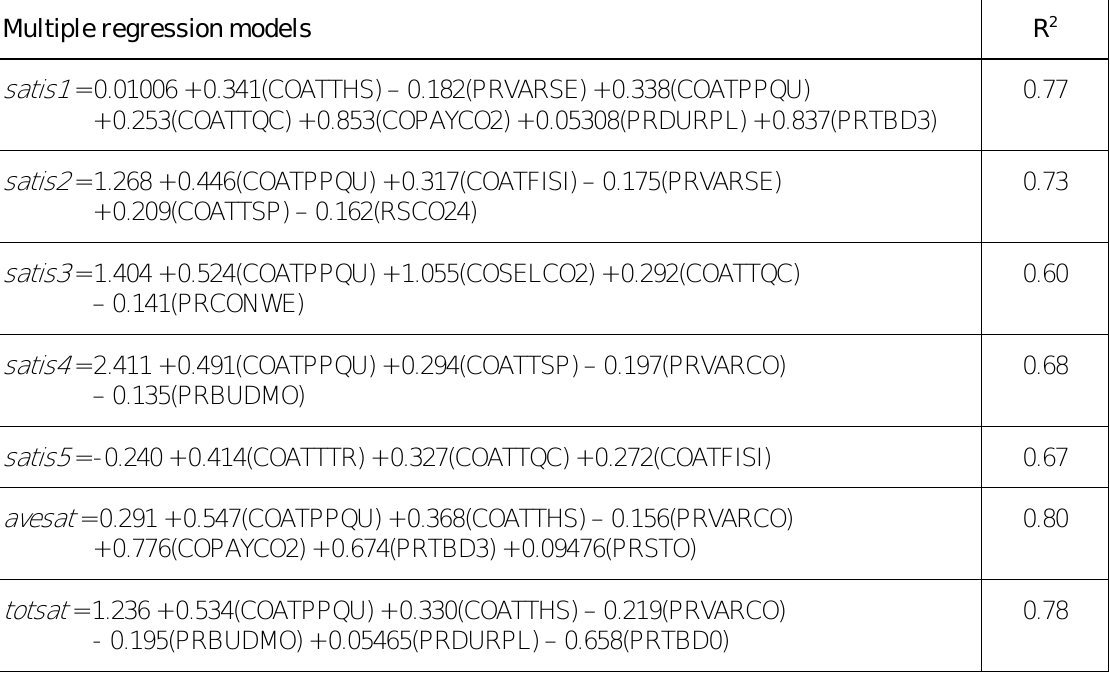
Table 4: MR models of clients’ satisfaction Multiple regression